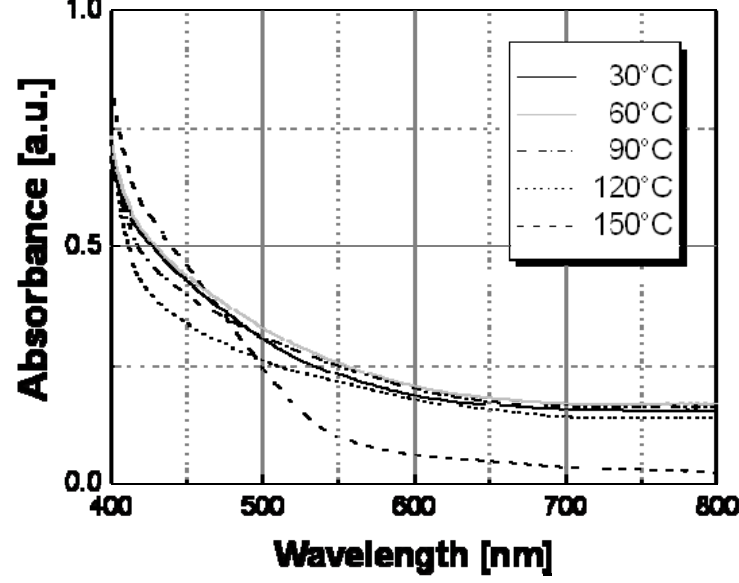
Figure 9. Absorption spectra at different temperatures of Ag/PS nanocomposite